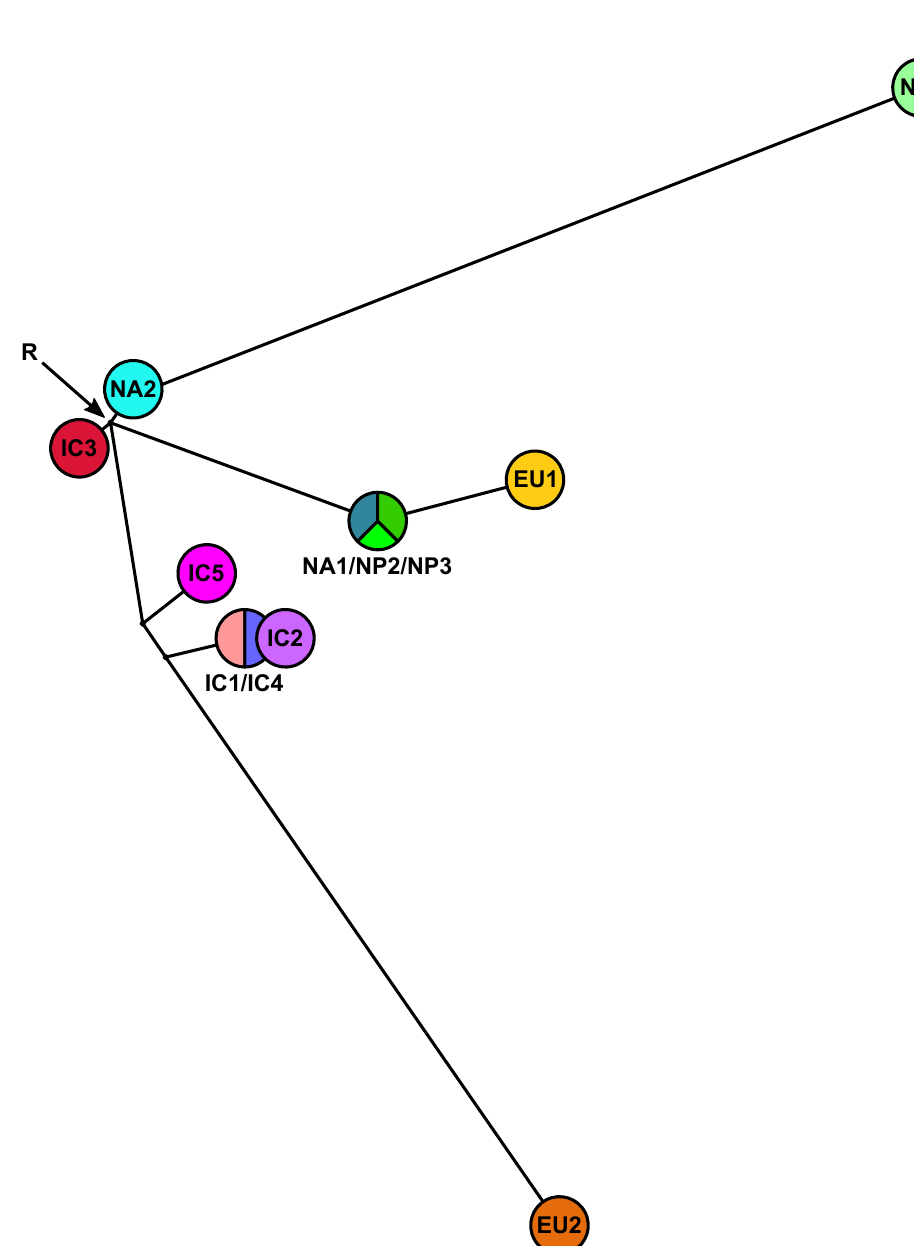
Figure 11. Median-joining network (MJN) with tolerance ε = 0 for the five Indochinese lineages (IC1-5), the three Japanese lineages (NP1-3) and the four known lineages (EU1, EU2, NA1 and NA2) of Phytophthora ramorum , based on a five-locus mitochondrial ( cox1 , cox2 , nadh1 , Prv8 and Prv9) dataset. The node with the highest number of connections and the most central position was designated as root (R). Missing intermediates represent extant unsampled genotypes, extinct ancestors or “false-positives”. Branch lengths are proportional to the number of